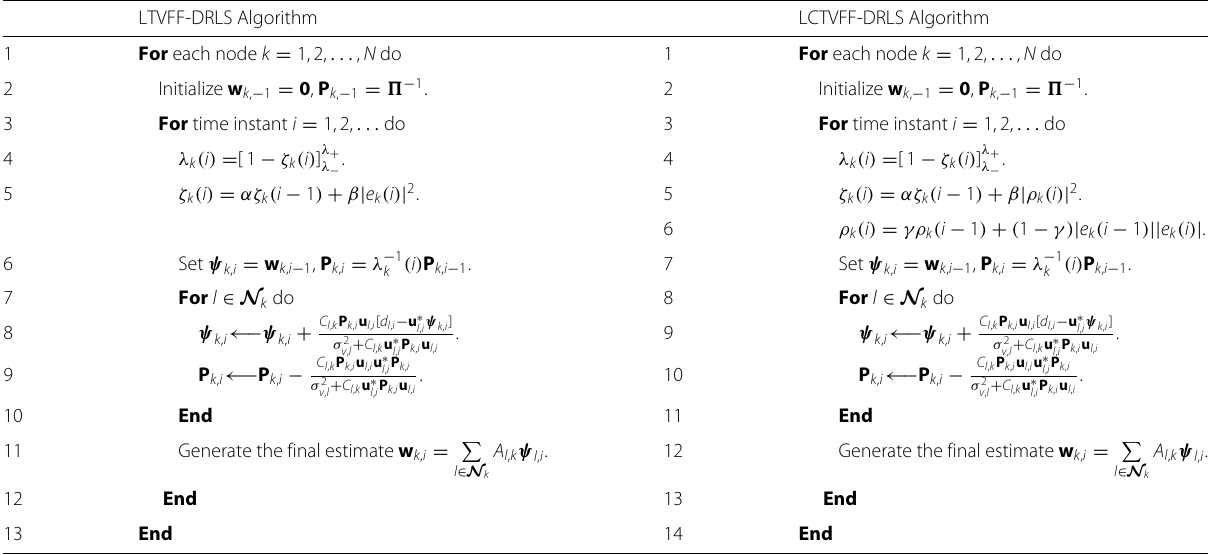
Table 1 LTVFF-DRLS and LCTVFF-DRLS algorithms LTVFF-DRLS Algorithm LCTVFF-DRLS